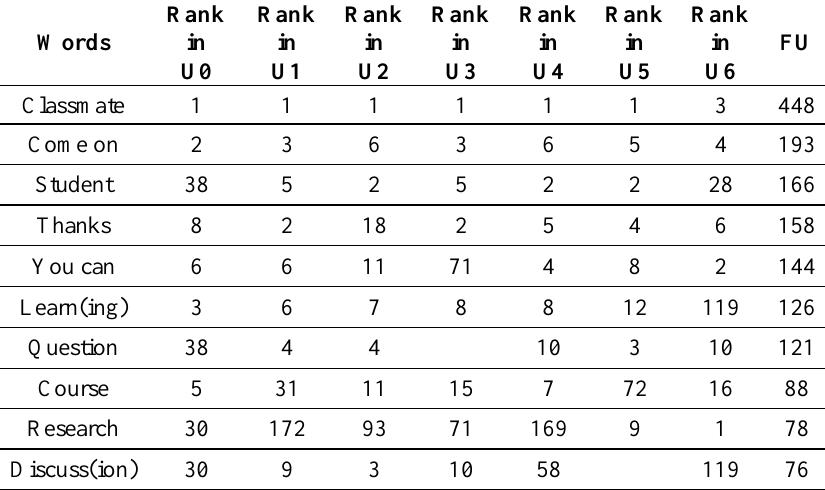
Table 5 Top 10 words and their order in